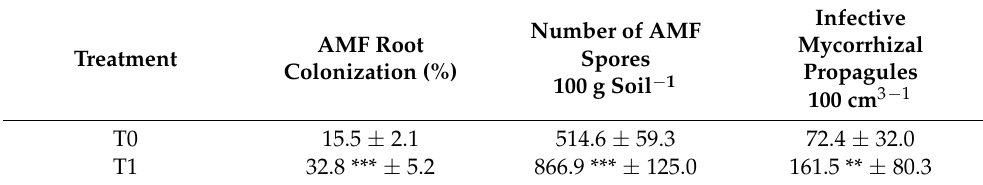
Table 4. Effects of biochar addition on AMF measurements at the end of the multiplication process